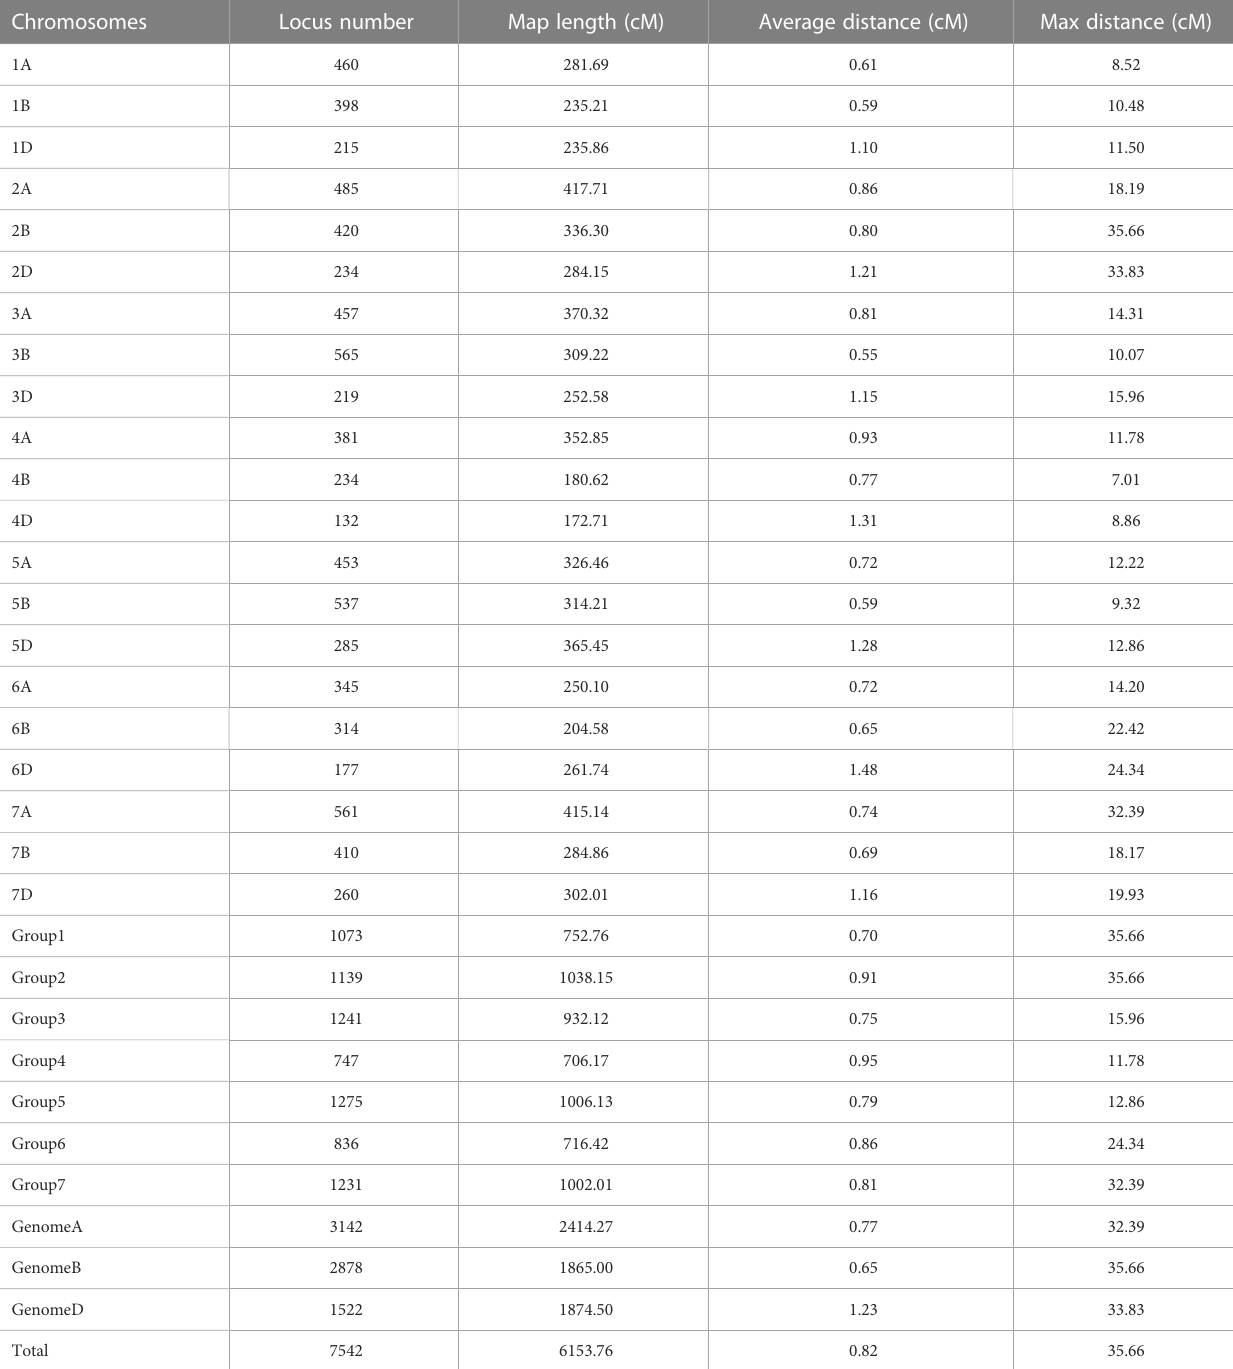
TABLE 1 Summary information of the Xiaoyan 54/Jing 411 RIL high-density genetic map. Chromosomes Locus